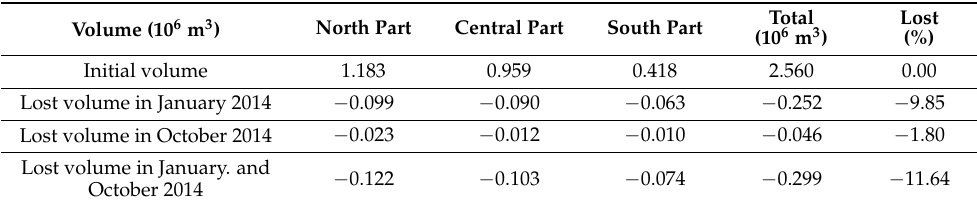
Table 5. Sandbar lost volume in January and October 2014.